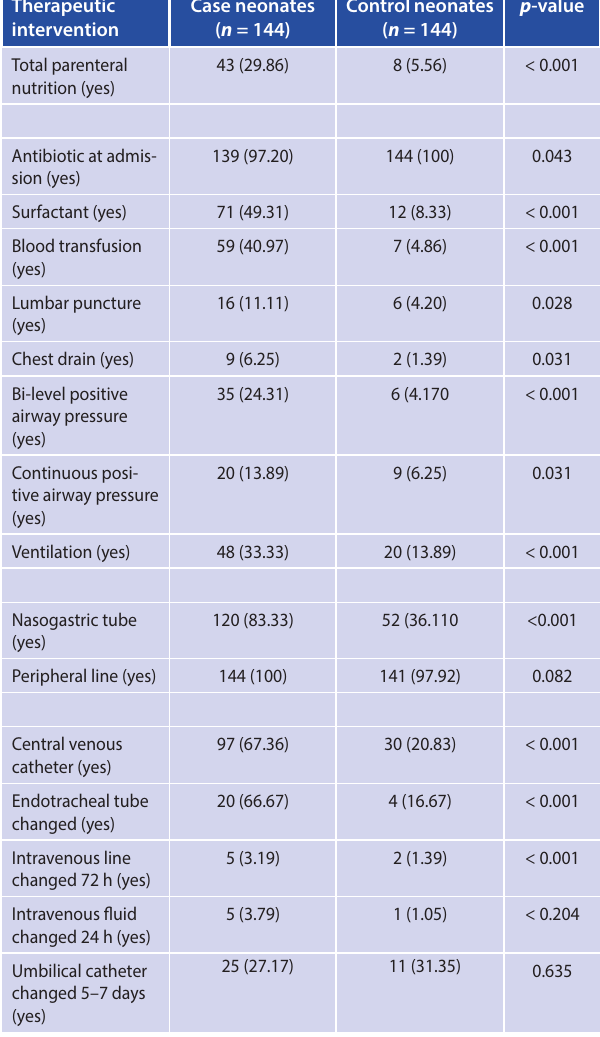
Table 3: Therapeutic interventions associated with the occurrence of nosocomial infection among hospitalised neonates from 2014 to 2015 ( n = 288) Therapeutic